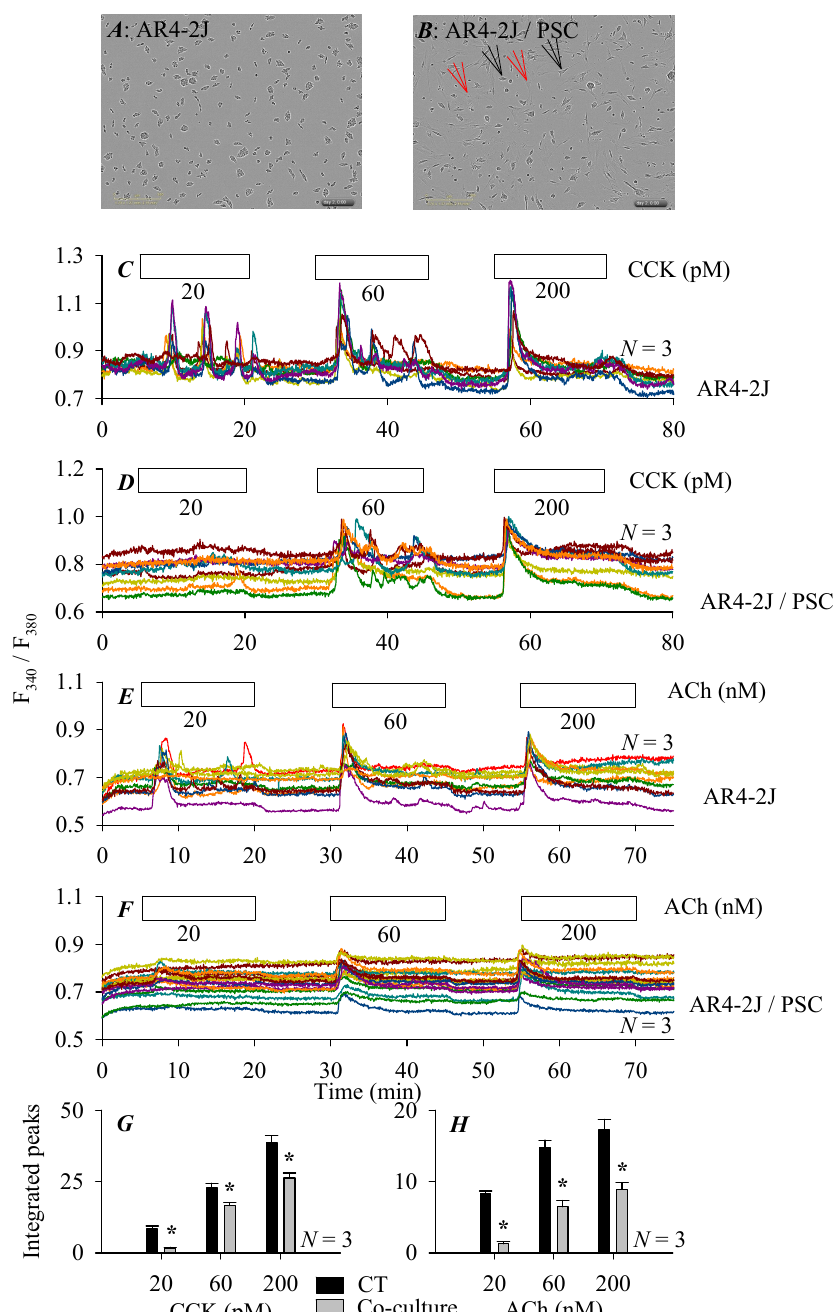
Figure 5. AR4-2J/PSC co-culture inhibition of CCK- and ACh-stimulated calcium increases in AR4-2J cells. AR4-2J cells cultured alone ( A ) or co-cultured with pancreatic stellate cells (at AR4-2J/PSC ratio of 2:1) ( B ) at 48 h of culture or co-culture (imaged by Incucyte). Fura-2-loaded AR4-2J ( C, E ) or AR4-2J/PSC ( D, F ) were perfused, CCK (20, 60, 200 pM, C, D ), ACh (20, 60, 200 nM) ( E, F ) were added as indicated by the horizontal bars. Color-coded calcium tracings in each panel ( C - F ) were from individual AR4-2J cells in a typical experiment. The integrated calcium peaks (area under the peaks above the basal calcium levels) were quantified, CCK- ( G ) or ACh- ( H ) induced calcium responses in control ( C , E ) or co-cultured ( D , F ) AR4-2J cells were compared. Asterisk (*) indicate statistical significance at p < 0.05, N = 3. The scale bars are 300 μ m in ( A , B ). Black and red arrows indicate AR4-2J and pancreatic stellate cells respectively in the co-culture ( B ). Enlarged versions of the micrographs ( A , B ) are presented as Figure A2 in Appendix A.